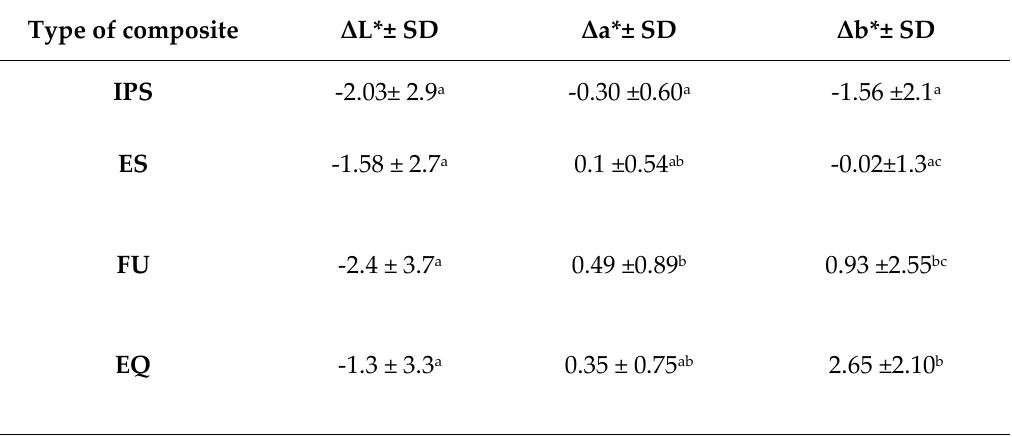
Table (2). Mean± SD values of color coordinates of different composite resin groups after 1-year